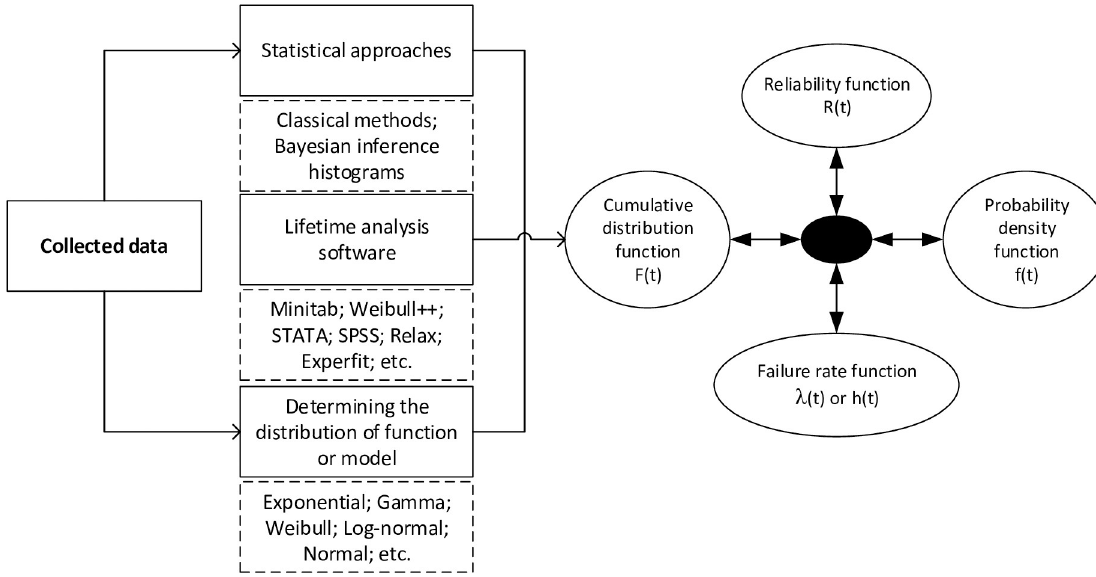
Fig 1. Data processing diagram in the reliability analysis; reprinted from Diallo et al. [14].